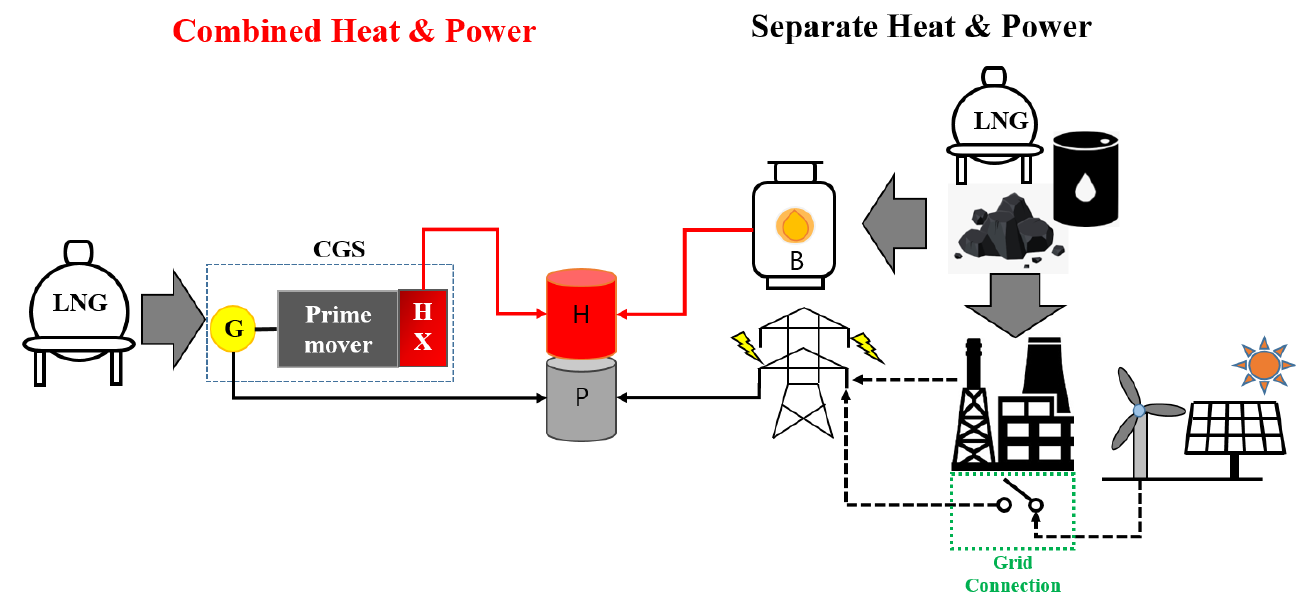
Figure 1. Illustrative diagram of the procedure to calculate RPES of CGS. Table 1. Information on the design and operating conditions of the investigated apartment complexes. Design